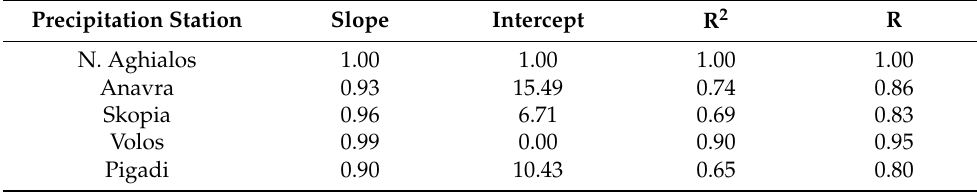
Table 3. Linear regression coefficients of the stations for the precipitation variable.